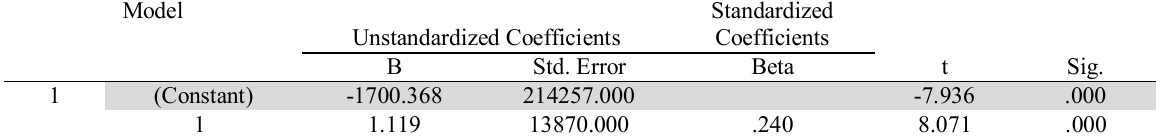
The results of regression analysis (Dependent variable = NPR)